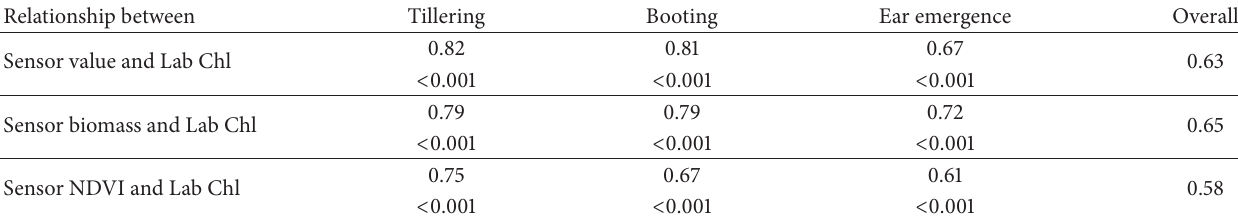
Table 2: Pearson correlation coefficients among different sensor attributes and Lab N at different growing stages of crop. Relationship between Tillering Booting Ear emergence Overall 0.85 0.63 0.64 Sensor value and Lab N < 0.001 < 0.001 < 0.001 0.87 0.610 0.57 Sensor biomass and Lab N < 0.001 0.0067 0.0132 0.90 0.49 0.41 Sensor NDVI and Lab N < 0.001 0.0364 0.0872 Table 3: Pearson correlation coefficients among different sensor attributes and Lab Chl at different growing stages of crop. Relationship between Tillering Booting Ear emergence Overall 0.82 0.81 0.67 Sensor value and Lab Chl < 0.001 < 0.001 < 0.001 0.79 0.79 0.72 Sensor biomass and Lab Chl < 0.001 < 0.001 < 0.001 0.75 0.67 0.61 Sensor NDVI and Lab Chl < 0.001 < 0.001 < 0.001